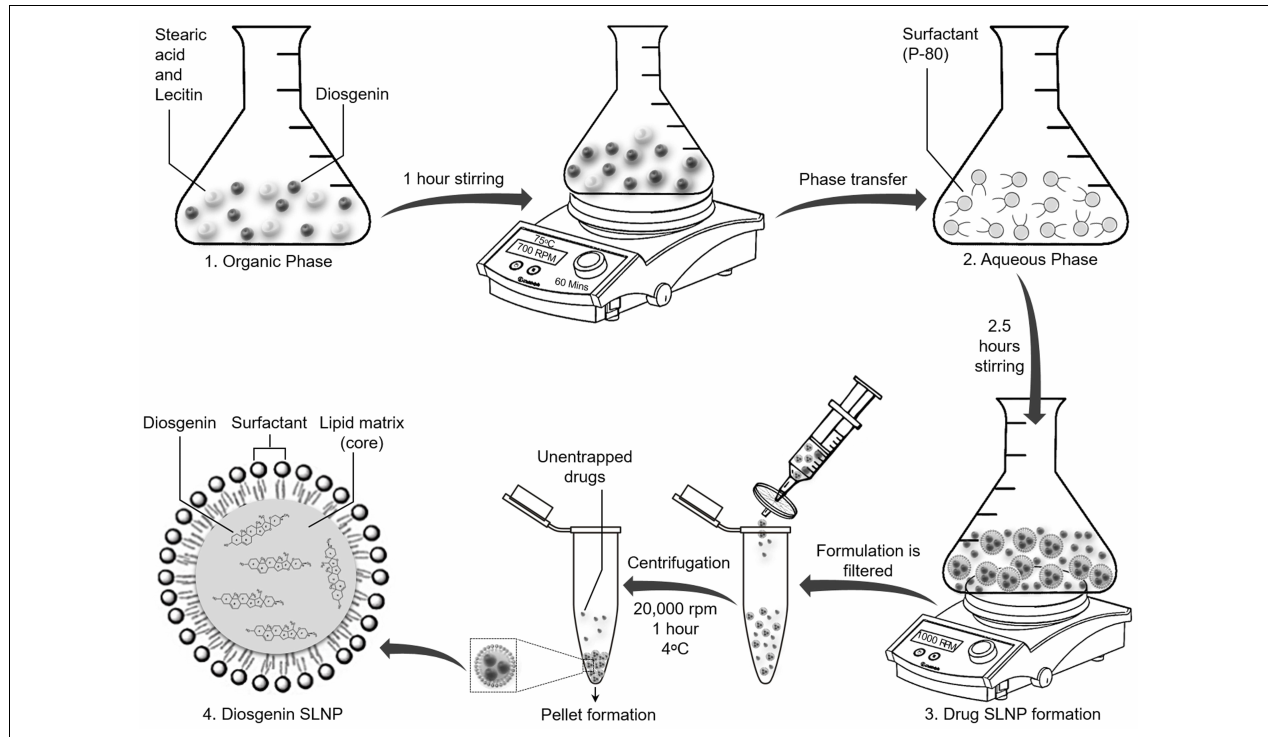
FIGURE 1 | Schematic diagram showing synthesis of solid lipid nanoparticles with encapsulated diosgenin. Lipids and diosgenin in organic phase were added in isopropanol. Hot organic phase was injected in aqueous phase with surfactant Tween 80 for coating purpose. Diosgenin solid lipid nanoparticles were formed following evaporation, centrifugation, and drying of pellet. Final structure of diosgenin solid lipid nanoparticles with Tween 80 coating has been presented at stage 4.